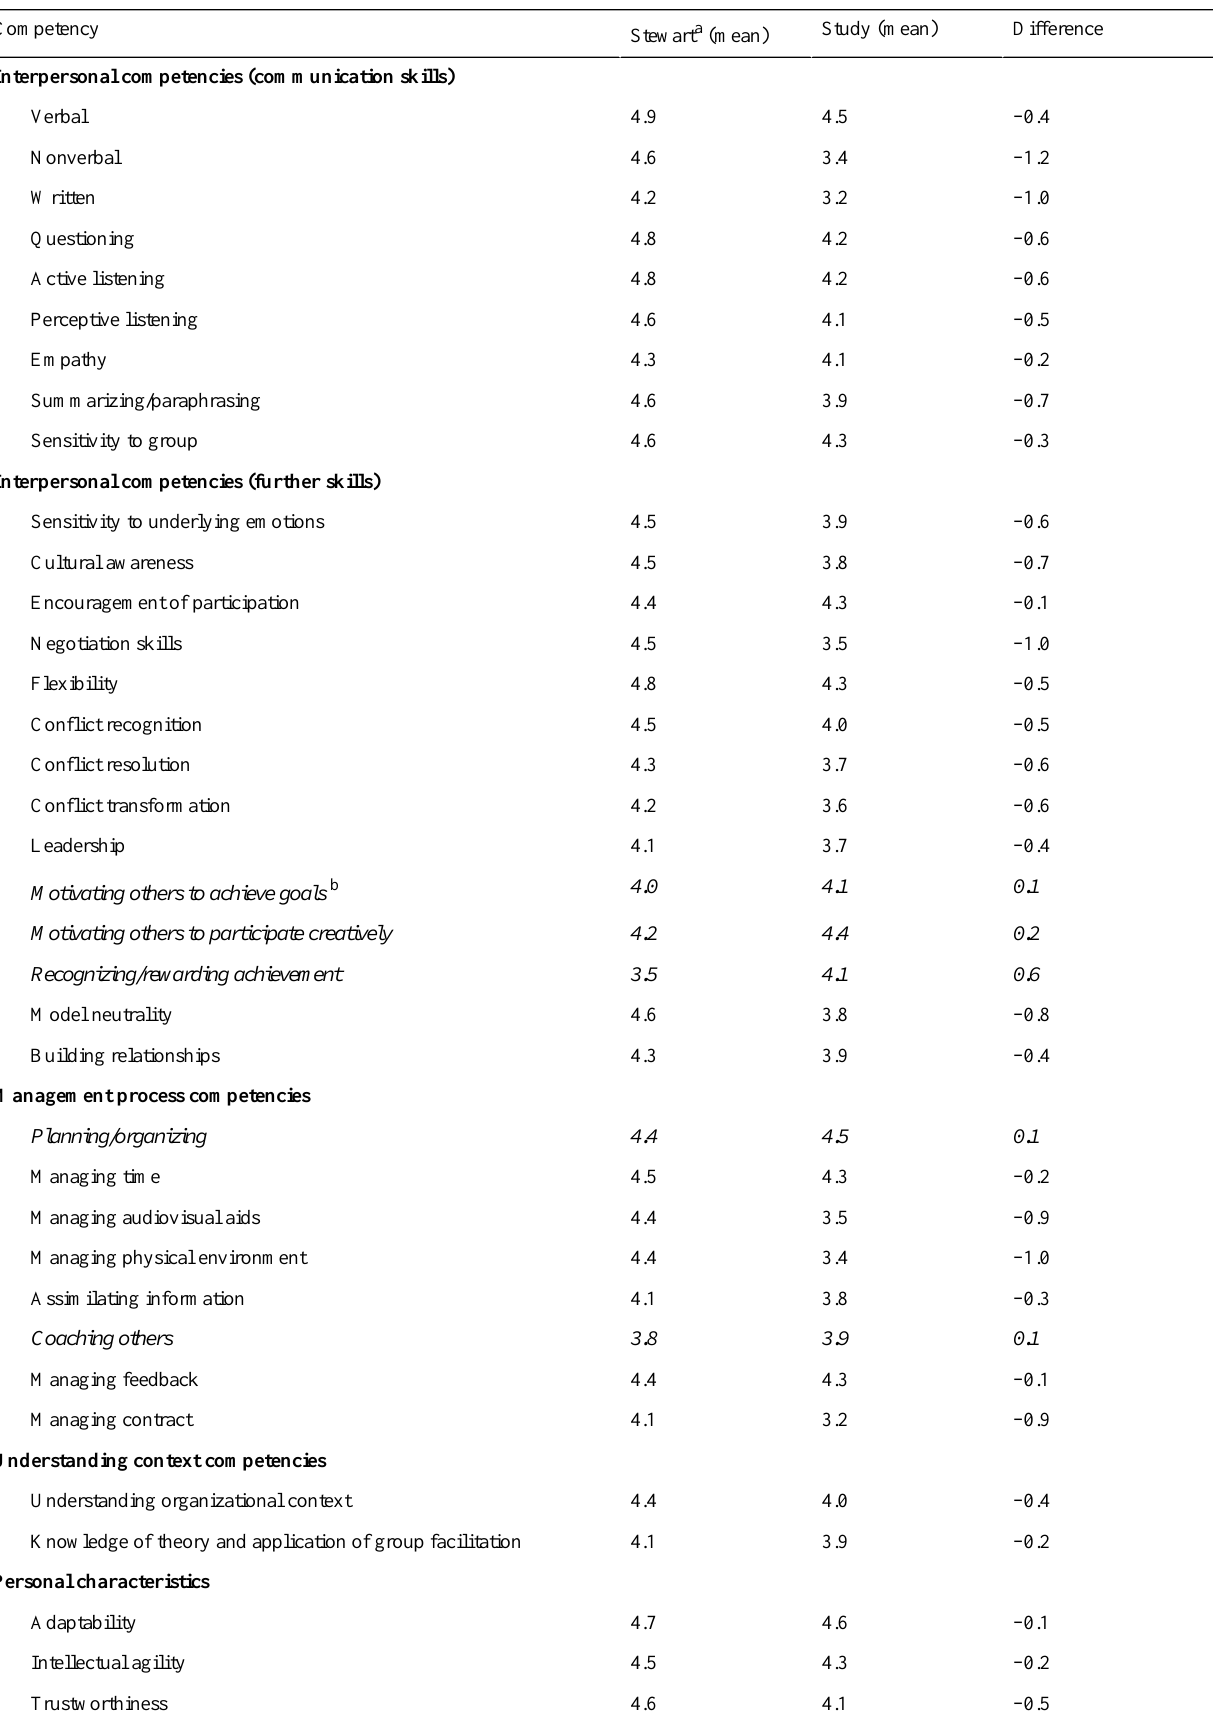
Table 2. Prioritization of competencies (5-point Likert scale; N=30).